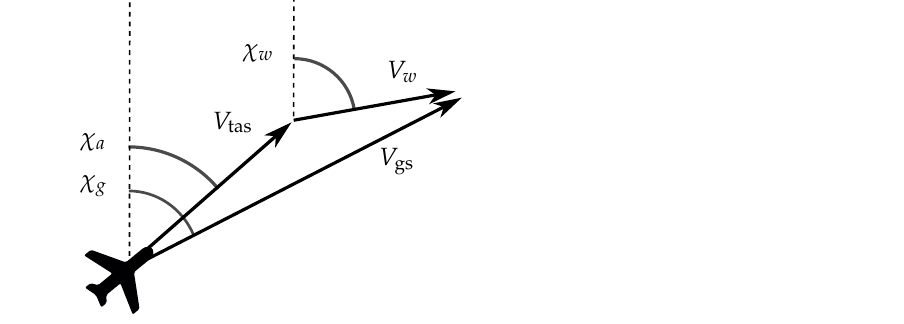
Figure 1. Relationship between true airspeed, ground speed, and wind vectors.